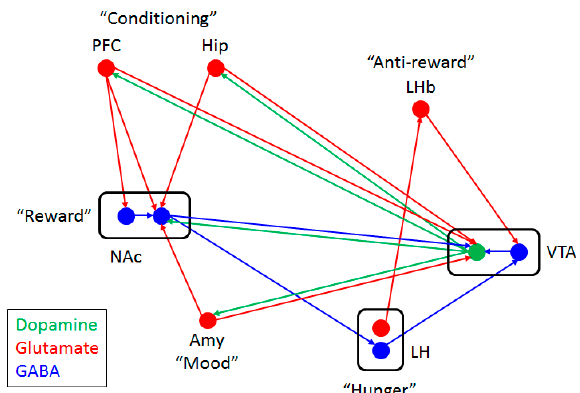
Figure 3. Neuronal circuit for Reward. Functions represented by each node are depicted in quotation marks. Circles indicate soma of neurons with arrows indicating projections. The color depicts which types of neurotransmitters are used. Abbreviations. Amy, amygdala; Hip, hippocampus; LH, lateral hypothalamus; LHb, lateral habenula; NAc, nucleus accumbens; PFC, prefrontal cortex; VTA, ventral tegmental area.